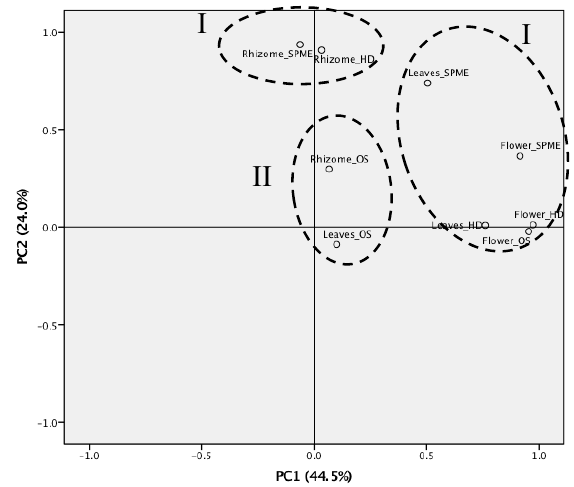
Figure 1. Principal component analysis (PCA) plots of all plant parts and extraction techniques.